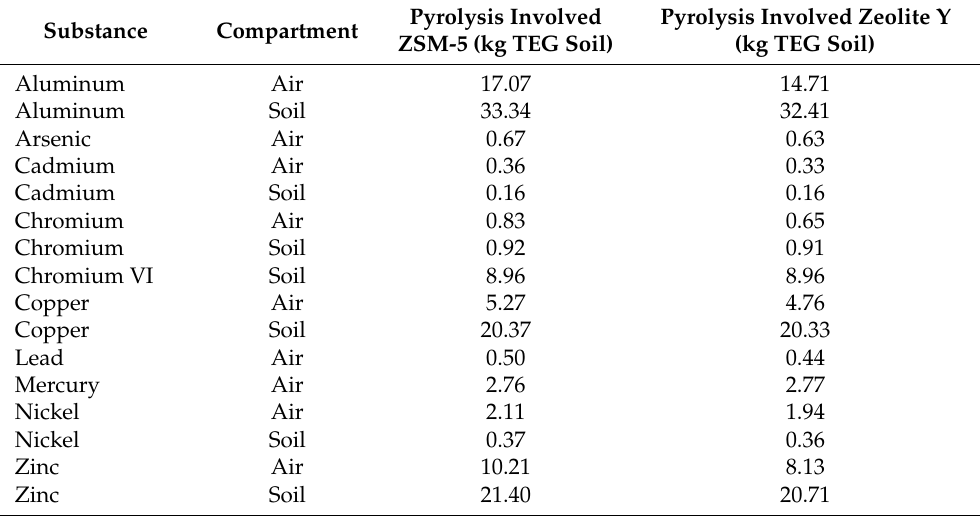
Table 8. Main heavy metals emitted to the air and soil in the catalytic pyrolysis